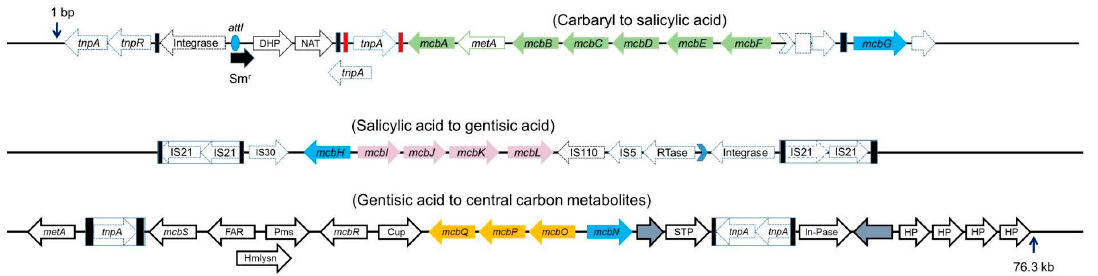
Figure 5. The organization of genes encoding enzymes responsible for Carbaryl degradation as three distinct transposons in Pseudomonas sp. strain C5pp. Genes are located on 76.3 kb long Supercontig-A (Accession number: KU522233.1). Inverted repeats (IRs) are depicted in red and black boxes. Arrow direction indicates the probable transcription direction. Blue color arrows depict genes encoding the probable regulators. Figure is not to the scale. Genes and protein encoded are transposase ( tnpA and tnpR ); integrase; attI site; streptomycin resistance ( Sm r ); dihydropterate synthetase (DHP); N-acetyl transferase (NAT); mcbA , Carbaryl hydrolase; metA , conserved protein; mcbB, 1,2-dihydroxynaphthalene dioxygenase; mcbC , 1-naphthol 2-hydoxylase; mcbD , 2-hydroxychromene 2-carboxylate isomerase; mcbE , trans - o -hydroxybenzylidene pyruvate hydratase-aldolase; mcbF , salicylaldehyde dehydrogenase; mcbG , LysR family regulator flanked by truncated transposons (depicted as dotted lines). IS21 insertion elements with inverted repeats; IS30 insertion element; mcbH , transcriptional regulator NahR; mcbI , ferredoxin reductase; mcbJ , salicylate 5-hydroxylase large oxygenase component; mcbK , salicylate 5-hydroxylase small oxygenase component; mcbL , ferredoxin; other transposase and insertion elements present downstream of the transposon. metA , conserved protein; tnpA, transposase; mcbS , TetR family transcriptional regulator; FAR, fusaric acid resistance; Hmlysn, hemolysin; Pms, permease; mcbR , LysR family transcriptional regulator; Cup, pirin and cupin2 superfamily related protein; mcbQ , maleylpyruvate isomerase; mcbP , fumaryl pyruvate hydrolase; mcbO , gentisate dioxygenase; mcbN , LysR family transcription regulator; transposase; STP, serine / threonine phosphatase; tnpA, transposase; In-Pase, inositol phosphatase; recombinase; HP, hypothetical